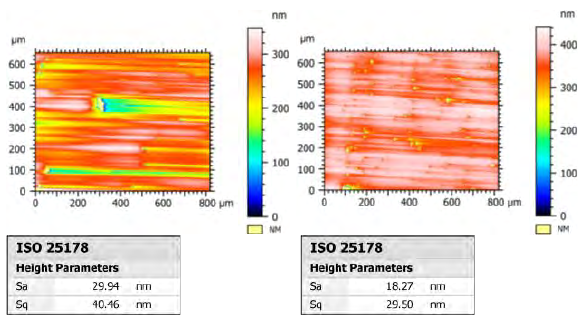
Fig . 14 . Comparsion of the partly polished zones of the sample grinded with D151 (left) and D30 (right) tool measured with white light interferometer. Lateral resolution of both Table 6 . Possible production processes and the optimal mesurement is 1.22 – 780 mm -1 . process marked in bold.